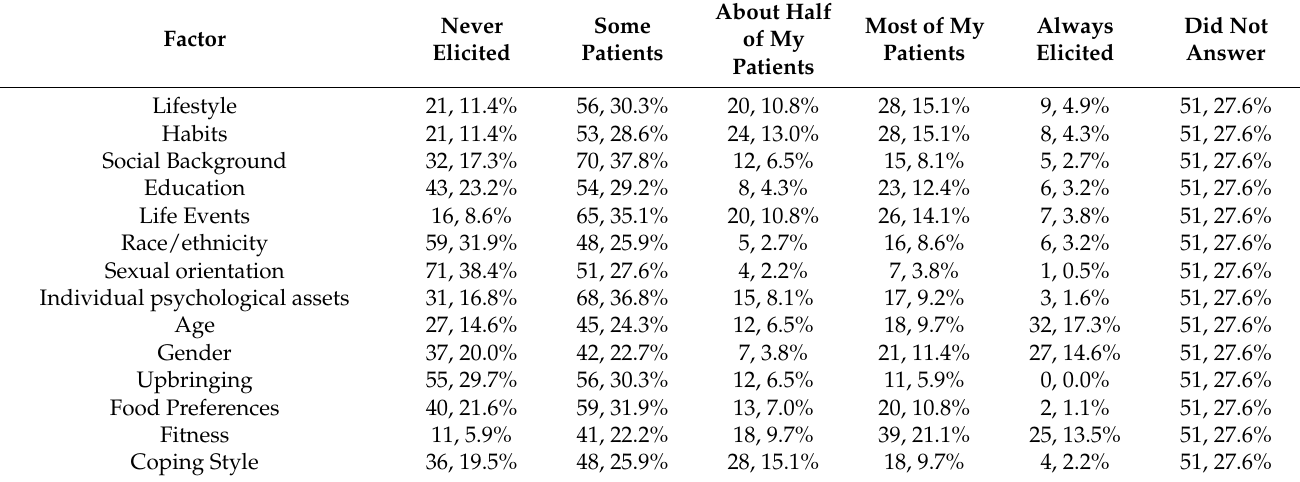
Table 9. Participant Report of Screening in Clinical Practice for Personal Factors ( n ,